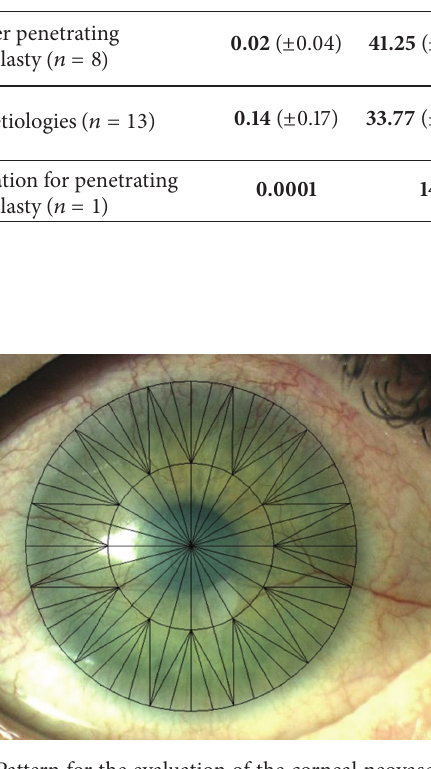
Figure 1: Pattern for the evaluation of the corneal neovasculariza-